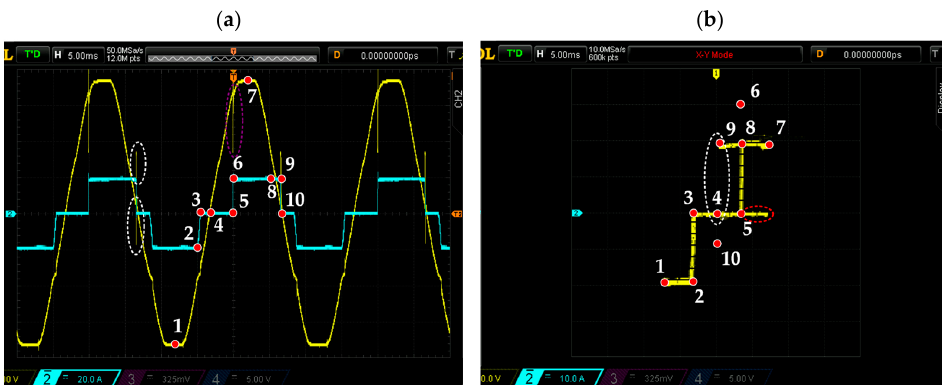
Figure 14. Recorded phase voltage and current waveforms on the AC grid side ( a ) and corresponding u–i characteristic ( b ) of the semiconverter. Firing angle α = 45 ◦ .